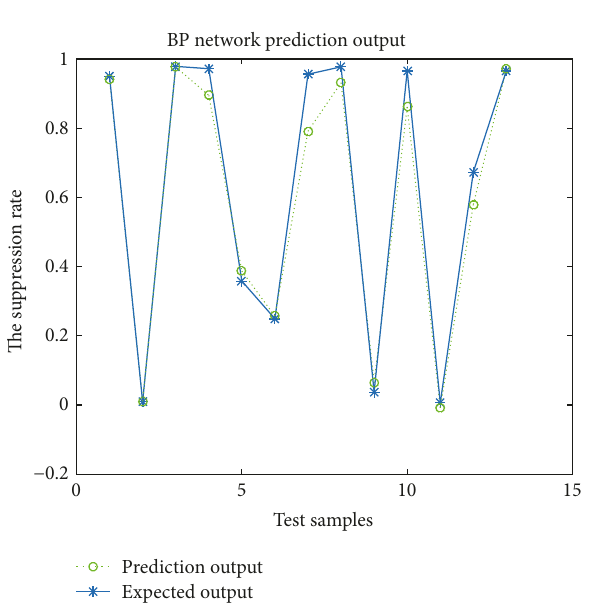
Figure 18: BP neural network prediction results.